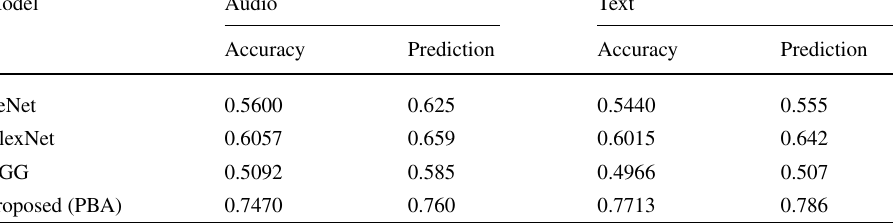
Table 4 The comparison results of audio and